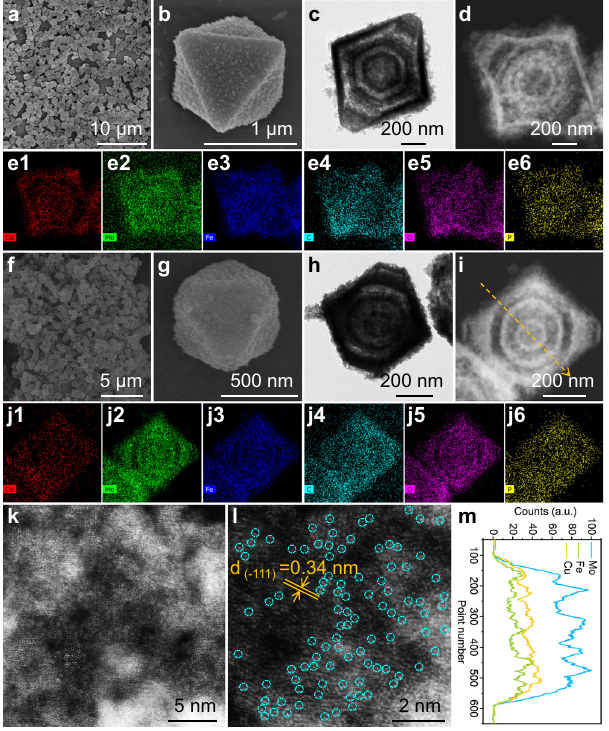
Fig. 2 Morphological and structural characterization. a , b SEM, c TEM, d HAADF-STEM, and e1 – e6 EDX mapping images of Fe-NENU-5. f , g SEM, h TEM, i HAADF-STEM, j1 – j6 EDX mapping, k , l AC HAADF-STEM images, and m elemental line scan pro fi les of Cu 4 /Fe 0.3 Mo 0.7 O 2 @C (Supplementary Fig. 3f – j). Speci fi cally, a low FeCl 3 ∙ 6H 2 O loading (<0.05 g) leads to smooth external surfaces and solid yolk-shell nanostructures of Fe-NENU-5 (Supplementary Fig. 3f, j). Rough external surfaces and triple-shelled hollow nanostructures with irregular intershell gaps are observed at the FeCl 3 ∙ 6H 2 O usage of 0.10 g (Supplementary Fig. 3h). When the FeCl 3 ∙ 6H 2 O loading is higher than 0.20 g, the triple-shelled nanostructure collapses with results suggest that a 40 min period of cation exchanging with 0.15 g FeCl 3 ∙ 6H 2 O loading is appropriate for the formation of hollow triple-shelled nanostructure of Fe-NENU-5 (Fig. 2a – d). An annealing treatment is then carried out under Ar atmosphere